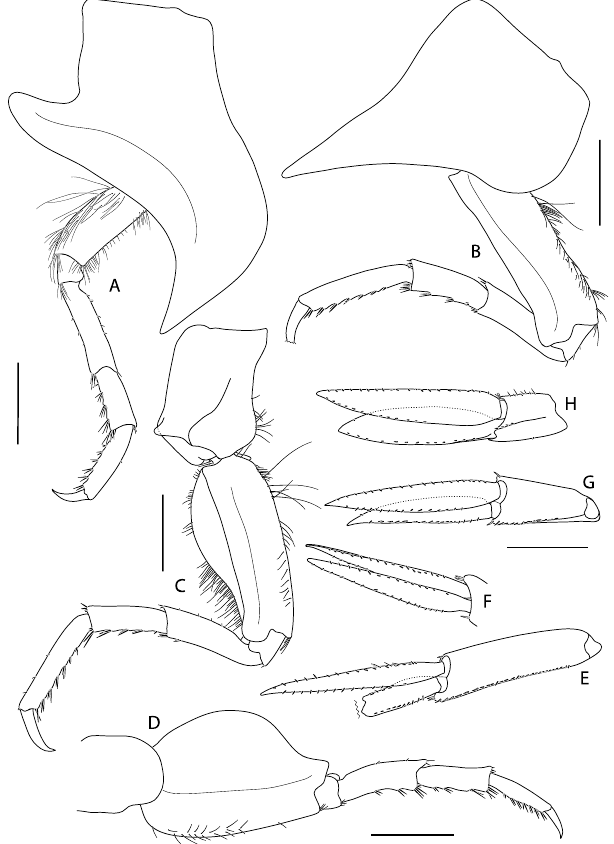
Figure 18. Epimeria cornigera , neotype, adult female, northern North Sea, NHMUK 2015.3268: ( A ) pereopod 4, ( B ) pereopod 5, ( C ) pereopod 6, ( D ) left pereopod 7 (drawn on habitus), ( E ) uropod 1 (outer ramus damaged), ( F ) rami of left uropod 1 (drawn on habitus), ( G ) uropod 2, ( H ) uropod 3; all scales 1 mm.